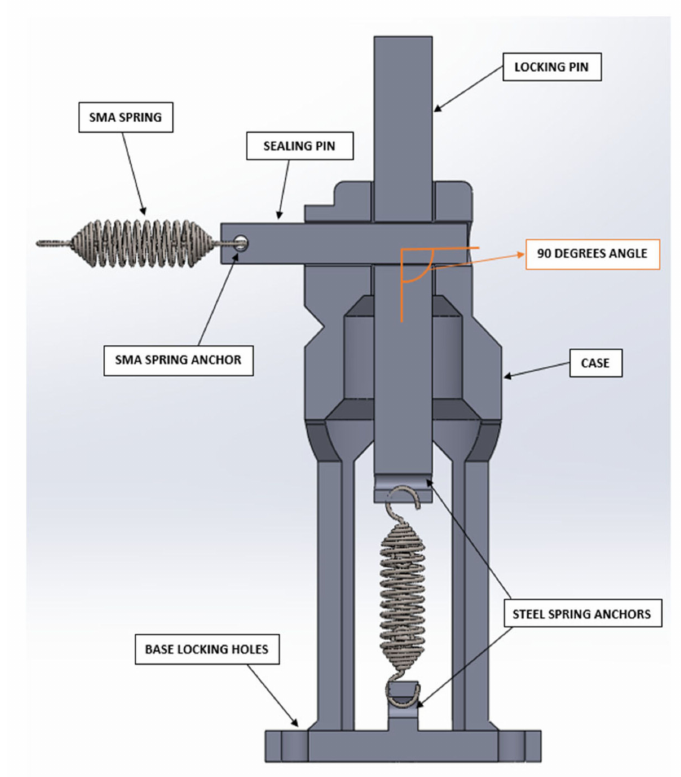
Figure 4. SMA actuator